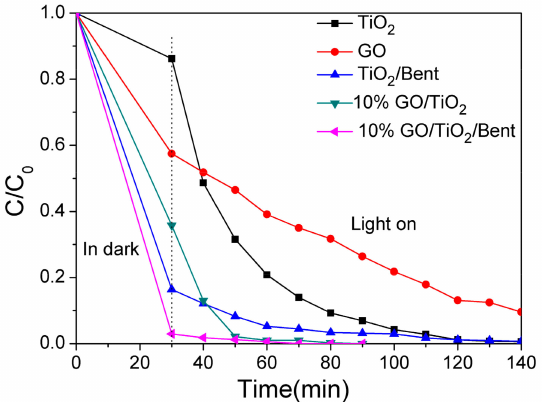
Figure 6. Removal rates of MB by di ff erent materials of TiO 2 , GO, TiO 2 / Bent, 10% GO / TiO 2 and 10% GO / TiO 2 / Bent sponge, respectively (Concentration of MB: 10 mg / L in 100mL MB solution; Mass of materials: 50 mg).